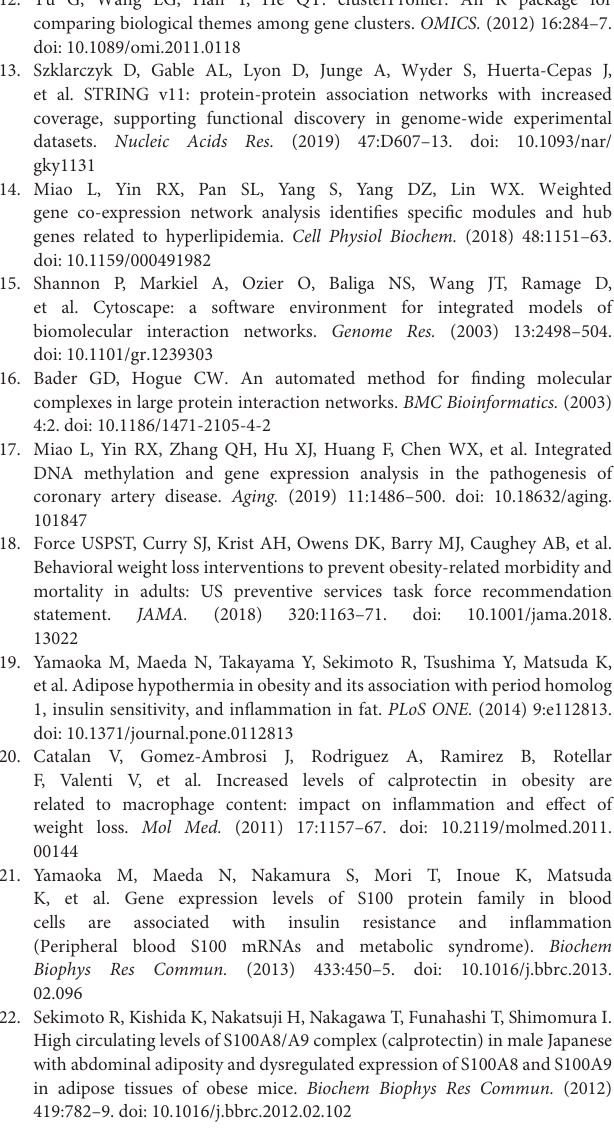
Supplementary Table 1 | The analysis for Gene Ontology. Supplementary Table 2 | The analysis for KEGG pathway. Supplementary Table 3 | The analysis for Disease